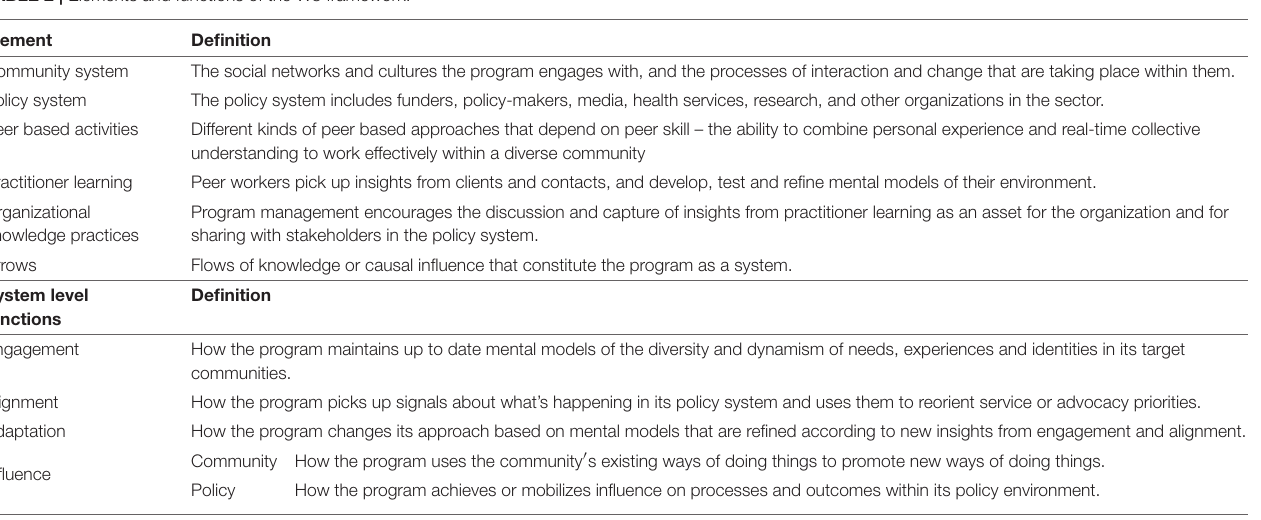
TABLE 2 | Elements and functions of the W3